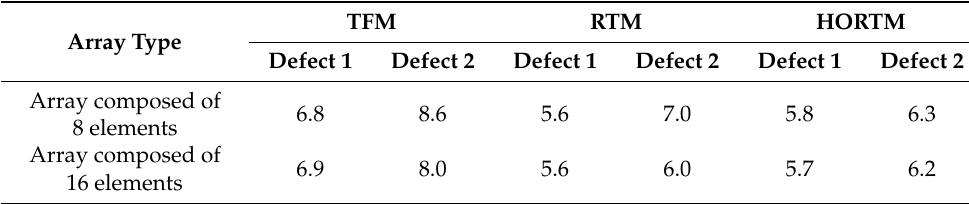
Table 3. Lateral width of − 6 dB for the defects in different imaging results